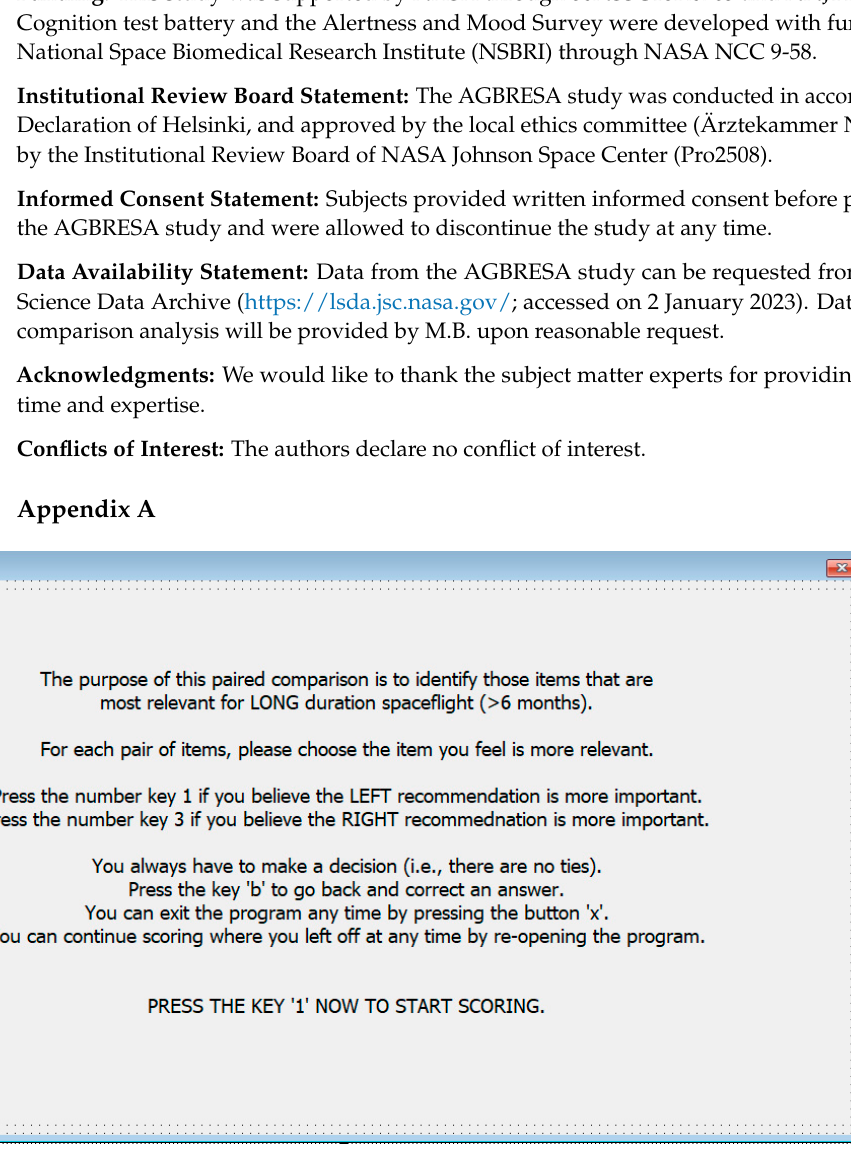
Figure A1. Screenshot of instructions for subject matter experts on how to operate the paired comparison software.